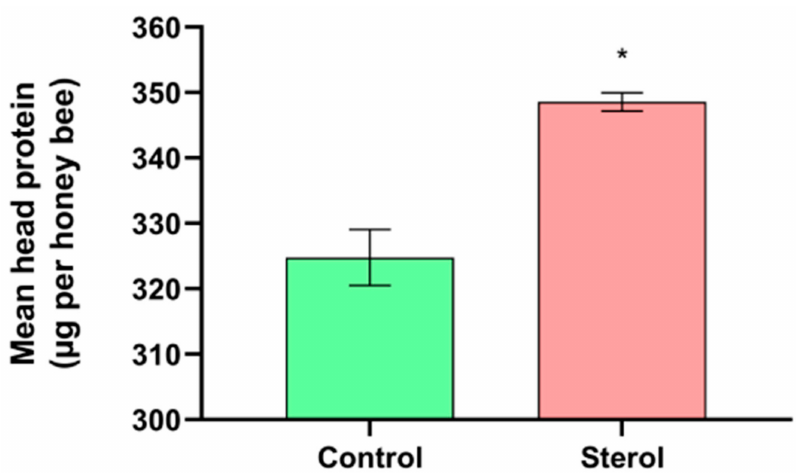
Figure 3. Mean head protein content ( µ g per bee) at the end of the four-week study. Control: bees fed diet with no sterol; Sterol: bees fed diet containing 0.25% 13 C-labeled 24-methylenecholesterol. Error bars indicate standard errors for means. * Indicates statistically significant di ff erences at p < 0.05. Likewise, at the end of the experiment, dietary sterol supplemented bees had higher mean abdominal lipid content than bees in the control group ( 13 C-24MC: 9.86 ± 0.08% dry abdominal weight;